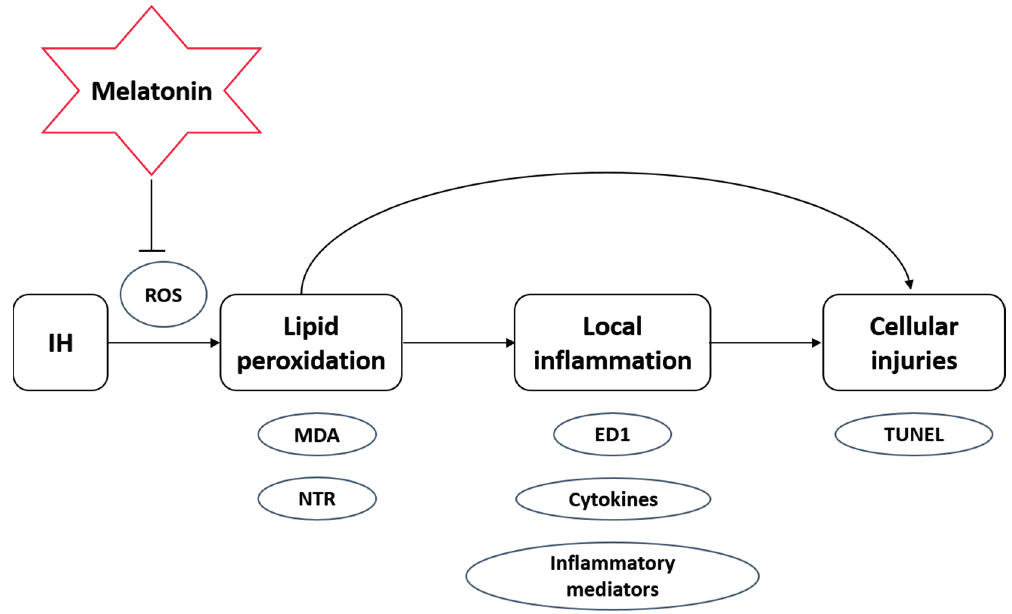
Figure 6. Melatonin ameliorates the cellular injuries in the adrenal medulla mediated by lipid peroxidation and inflammation induced by intermittent